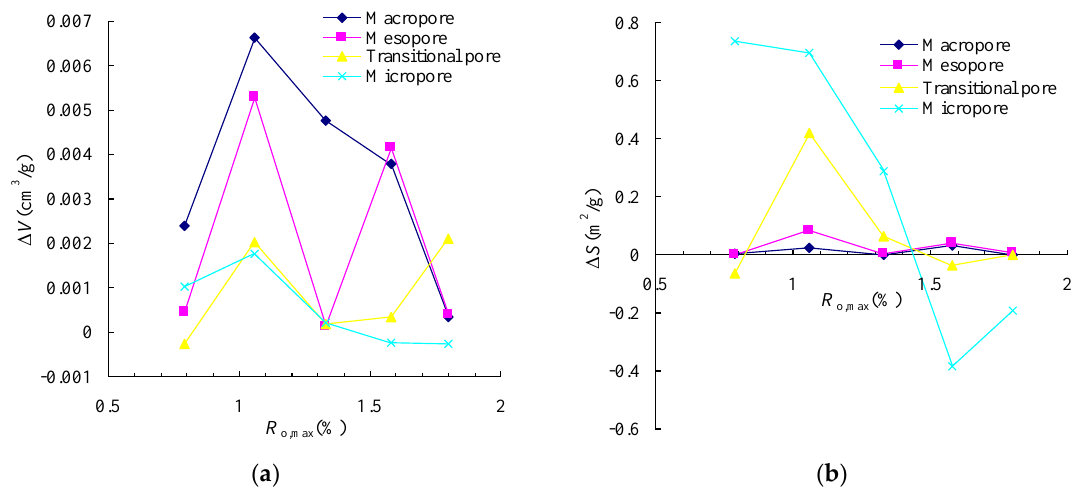
Figure 4. The changes of incremental pore volume and surface area of coal due to Sc-CO 2 extraction: ( a ) incremental pore volume change with coal rank increasing; ( b ) incremental pore surface area change with coal rank increasing.